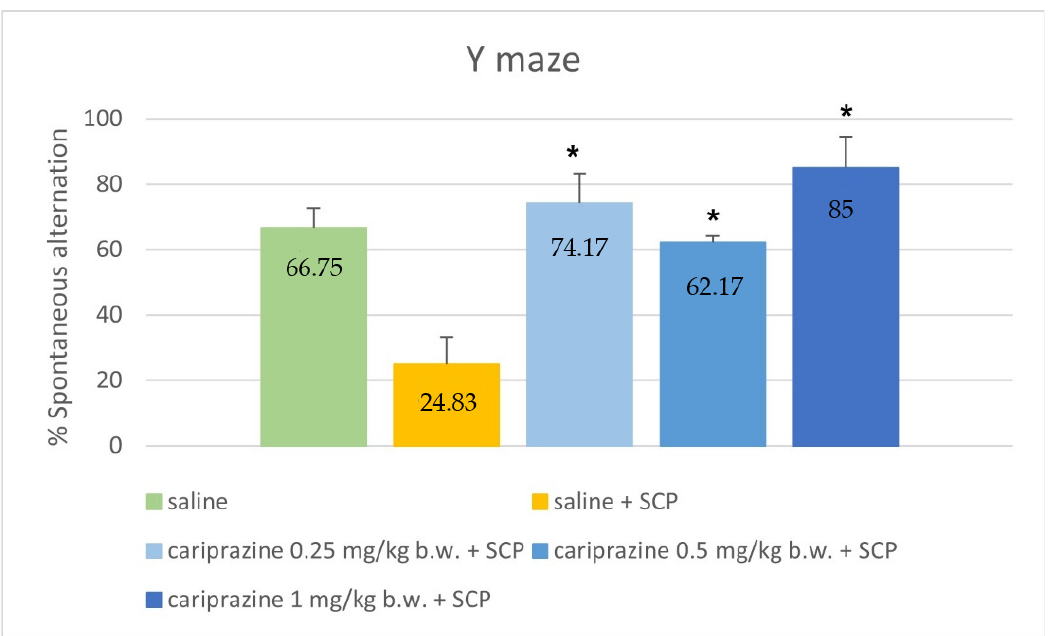
Figure 3. Comparison of spontaneous alternation values (percentage) between control groups and groups treated with cariprazine in the Y-maze task. SCP—scopolamine * p ≤ 0.05 compared to saline + SCP.